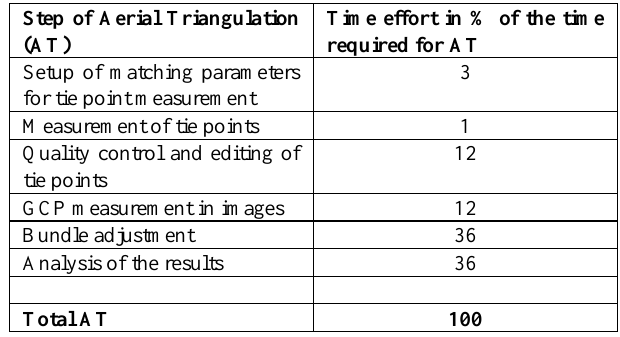
Table 2: Time effort required for the single steps of aerial triangulation as percentage of the total time